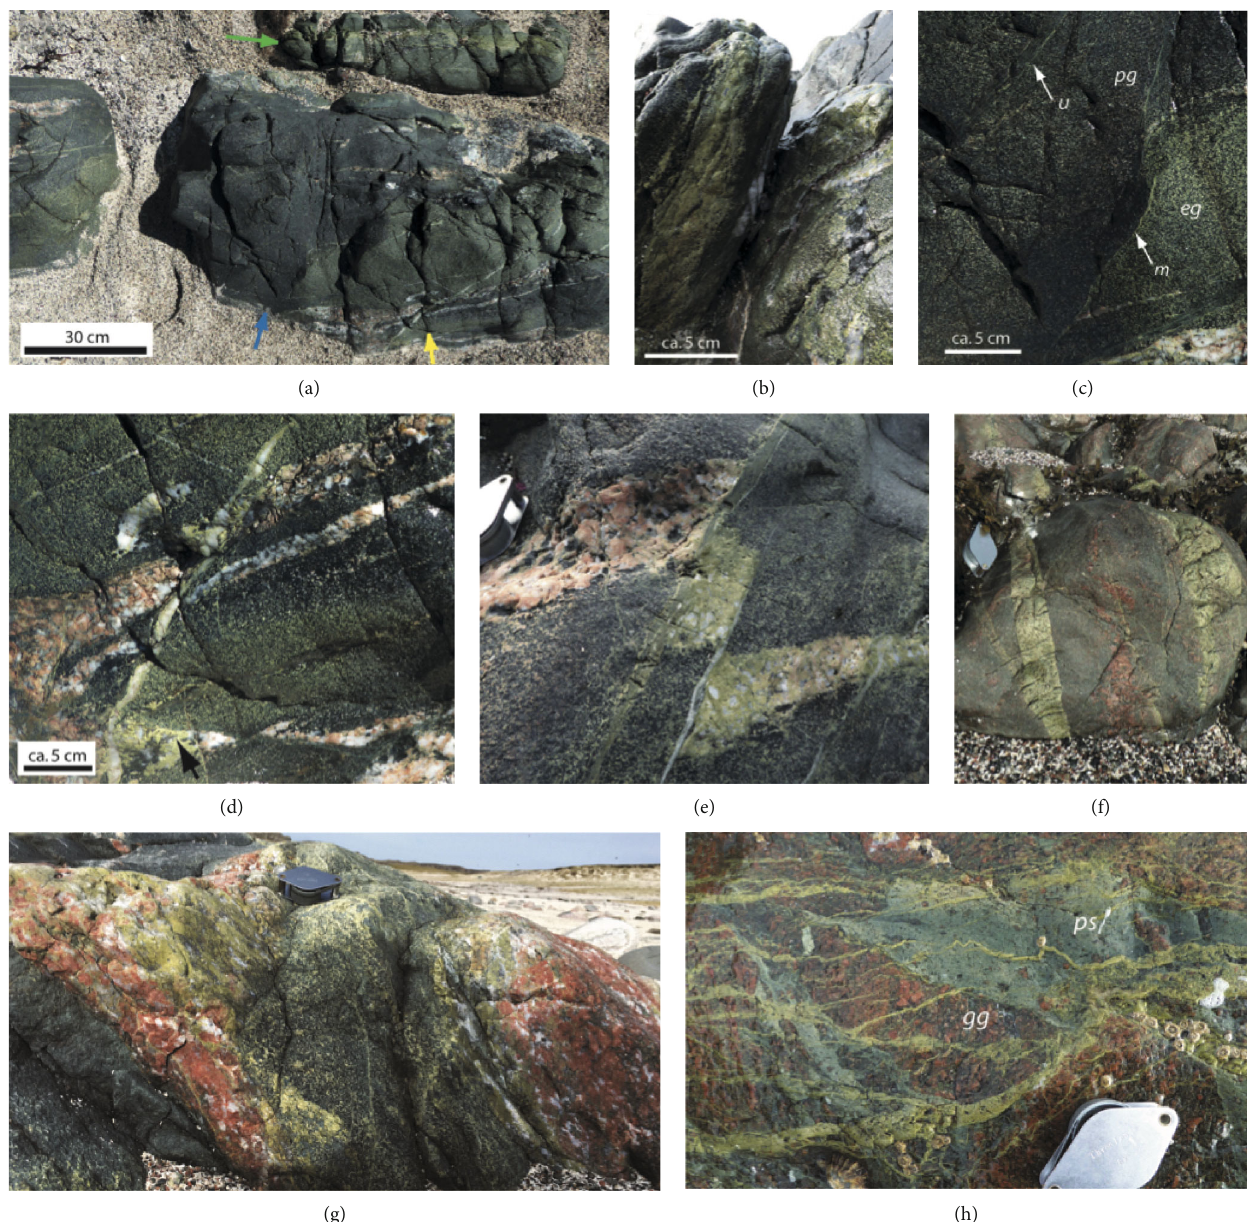
Figure 2: Field photographs of sampled exposures of gneisses. (a) Partially retrogressed metabasic gneiss blocks exposed in beach sand. Looking directly down on the exposure. Top of photograph represents a southeast direction. Elongate thin block towards the top of the view contains pale green 5 cm wide epidosite (marked by green arrow, shown in (b)). Blue arrow points towards the part of the exposure shown in (c); yellow arrow points to the view shown in (d). Positions of thin section samples F, G, H, and I are shown. Other thin sectioned samples are from adjacent blocks. (b) View of epidosite exposure looking towards the southwest with sand removed from the gully; (c) dark metabasic amphibole-rich gneisses with unmineralized (u) and mineralized (m) fractures, the latter is fi lled with pale green epidote and separates pervasively altered epidote-rich gneiss (eg) from relatively unaltered plagioclase-rich gneiss (pg); (d) metabasic gneiss with coarse pegmatite veins and hydrothermal veins fi lled with epidote and central zone of quartz. Gneiss in the central lower part of the view shows extensive alteration of plagioclase to green epidote and has an irregular boundary with the unaltered gneiss to the right of the view. Plagioclase in the pegmatite also locally shows extensive alteration to epidote (arrowed); (e) local alteration of feldspar-rich pegmatite to green epidote and associated epidote replacement of plagioclase in the host gneiss. Note the spatial restriction of alteration of the pegmatite by an epidote- fi lled cataclasite; (f) K-feldspar-bearing granitic gneiss with epidosite- fi lled fractures and limited pervasive retrogression of the host gneiss; (g) sheets of metabasic and granitic gneiss showing pervasive epidotization of plagioclase in the former and more limited alteration of feldspars restricted to the margins of the granitic gneiss; (h) epidote veins within pseudotachylite (ps) and highly fractured granitic gneiss (gg) with no obvious marginal alteration of either host. Hand lens for